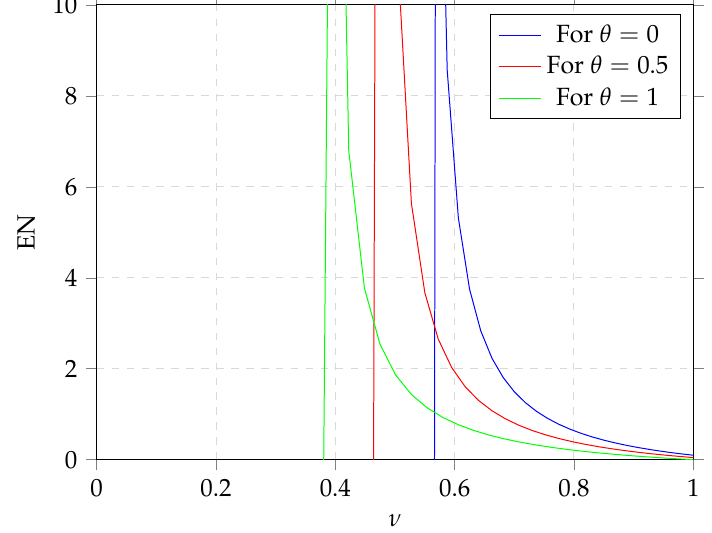
Figure 2. EN against ν .